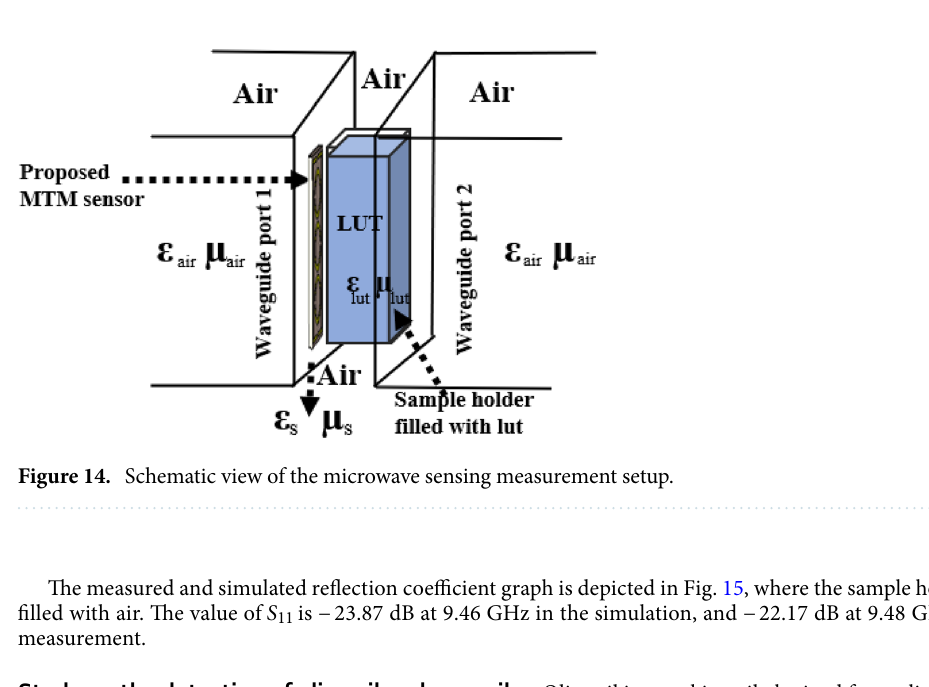
Figure 13. ( a ) Front view of fabricated MTM based sensor ( b ) back view ( c ) process of liquid insertion ( d ) experimental setup using waveguide ( e ) sensor attached with X-band waveguide and ( f ) sample holder attached with an extended guided wave.